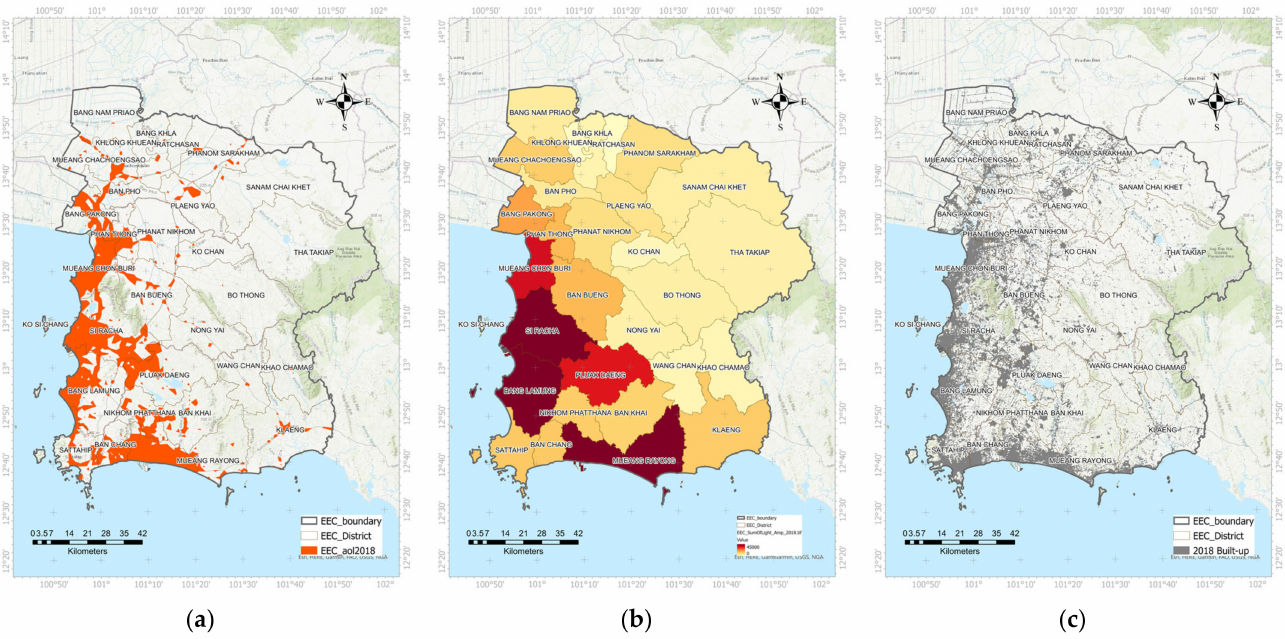
Figure 3. The examples of remotely sensed data extraction (Landsat 8 and NPP VIIRS DNB) of 2018 include: ( a ) area of lit, ( b ) sum of light intensity (nW cm − 1 sr − 1 ), and ( c ) built-up